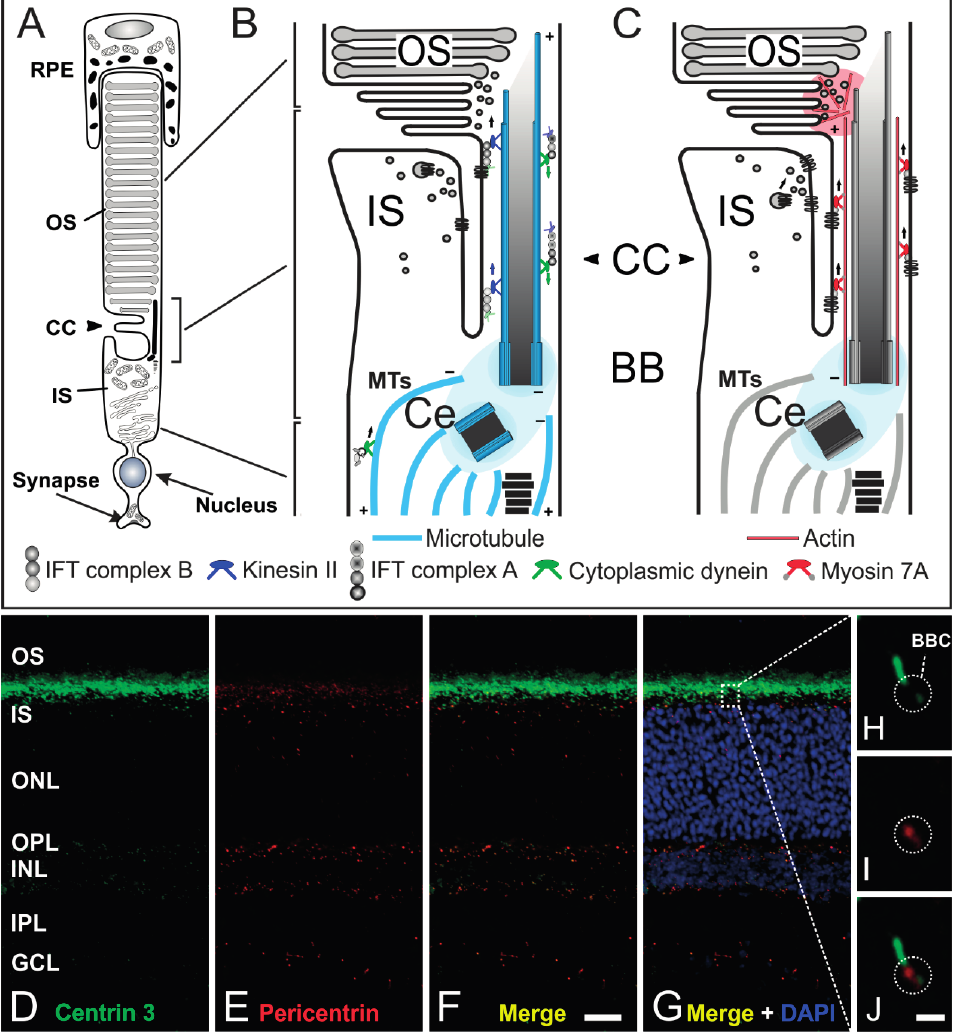
Figure 6. The connecting cilium of photoreceptors and its transport machinery. ( A ) Schematic of a vertebrate rod photoreceptor consisting of the light-sensitive outer segment (OS) enclosed by the retinal pigment epithelium (RPE) and linked via the connecting cilium (CC) to the metabolically active inner segment (IS); ( B , C ) Schematics of the two ciliary transport systems in photoreceptors; ( B ) Cargo transport to the CC is mediated along microtubules (MT) by cytoplasmic dynein 1 motor proteins (minus-end-directed). Delivery from the IS to the OS is mediated by IFT B molecules (binding the cargo) and kinesin II motor proteins (plus-end-directed). Delivery back to the IS is mediated by IFT A molecules and cytoplasmic dynein 2 motor proteins (minus-end-directed); ( C ) In addition, a myosin 7a-driven transport along actin filaments is used for trafficking proteins to the OS; ( D – G ) Confocal laser scanning micrographs of a vertical cryostat section through an adult mouse retina double labeled for Centrin 3 ( D , green ) and Pericentrin ( E , red ) as markers for the cilia and the basal body complex (BBC), respectively; ( F , G ) As seen in the merge of the stainings with additional labeling of the cell nuclei with DAPI, centrin 3 and pericentrin partially colocalize at the ciliary region of the photoreceptors and at the centrosomes of other retinal cells; ( H – J ) Higher power views showing the partial colocalization of centrin 3 and pericentrin at the BBC of photoreceptor-connecting cilia. Scale bars: 20 µm ( F ), 1 µm ( J